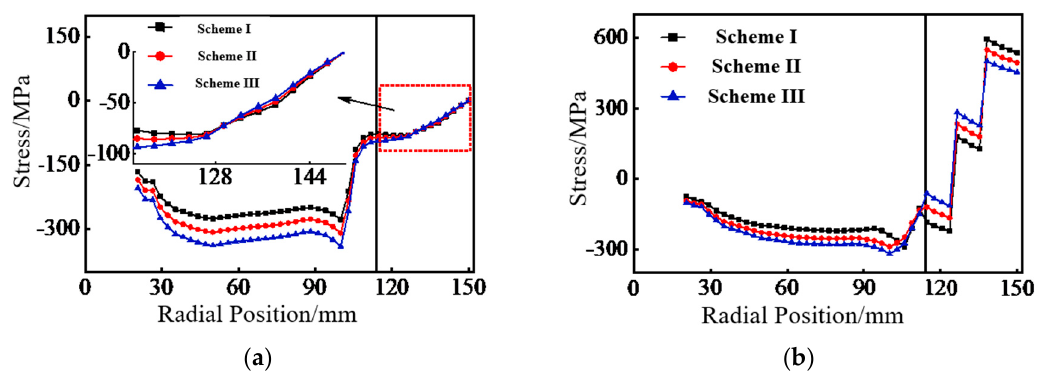
Figure 9. Stress curve of the flywheel at rest. ( a ) Radial stress curve; ( b ) hoop stress curve.